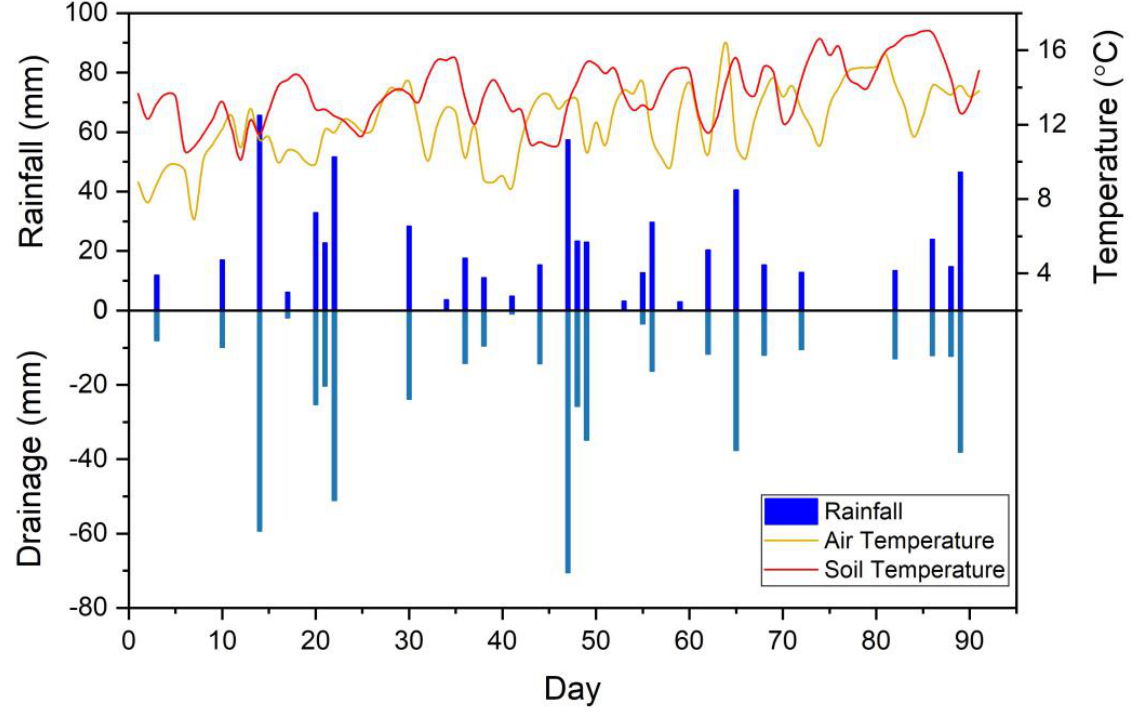
Figure 1. The climate data for the experimental period.